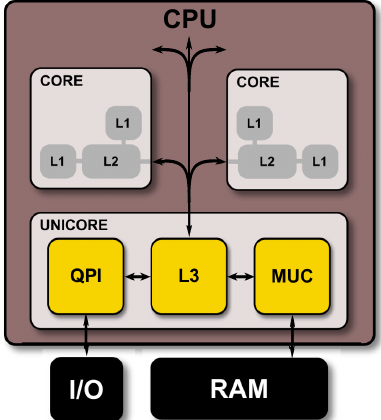
Figure 2. Architecture illustration resembles a generic CPU from Intel Xeon series [58] showing the interconnection of Quick Path Interconnect (QPI), Memory Control Unit (MCU), with caches and